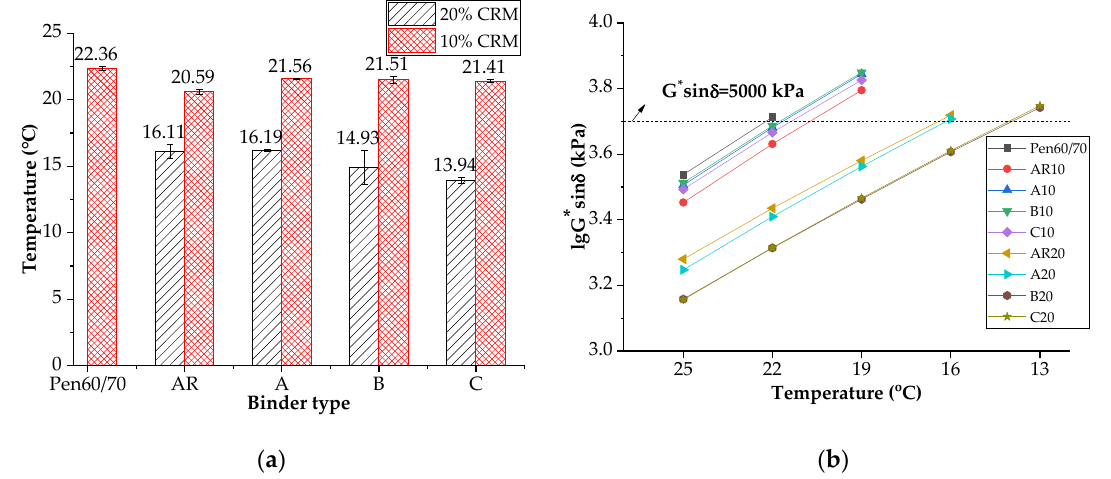
Figure 6. Fatigue performance of asphalt binders: ( a ) failure temperatures; ( b ) Logarithm of G * sin δ values (fatigue factors).